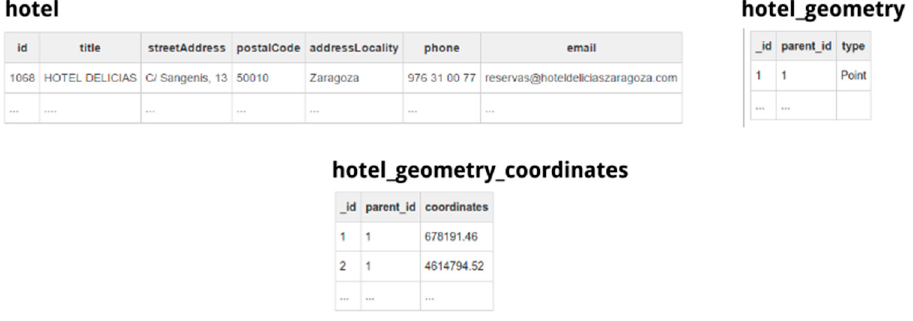
Figure 7. Data serialized in JSON format obtained from the execution of the SQL select statement.